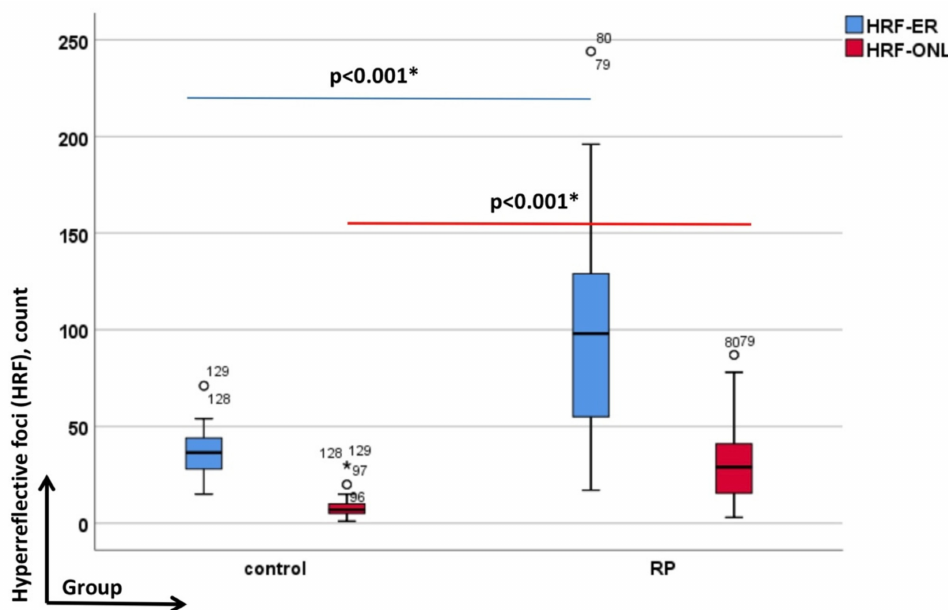
Figure 3. Depicts the data of HTF-ER blue-colored; and of the HRF-ONL red-colored. The box plot is the interquartile range; the short horizontal bold line depicts the median. In each graph the groups as labelled on the y-axis (from left to the right: controls and retinitis pigmentosa (RP) and the evaluated HRF-parameters—on the x-axis. All significant p -values are given in bold with asterisk and the numbered circles the outliers.